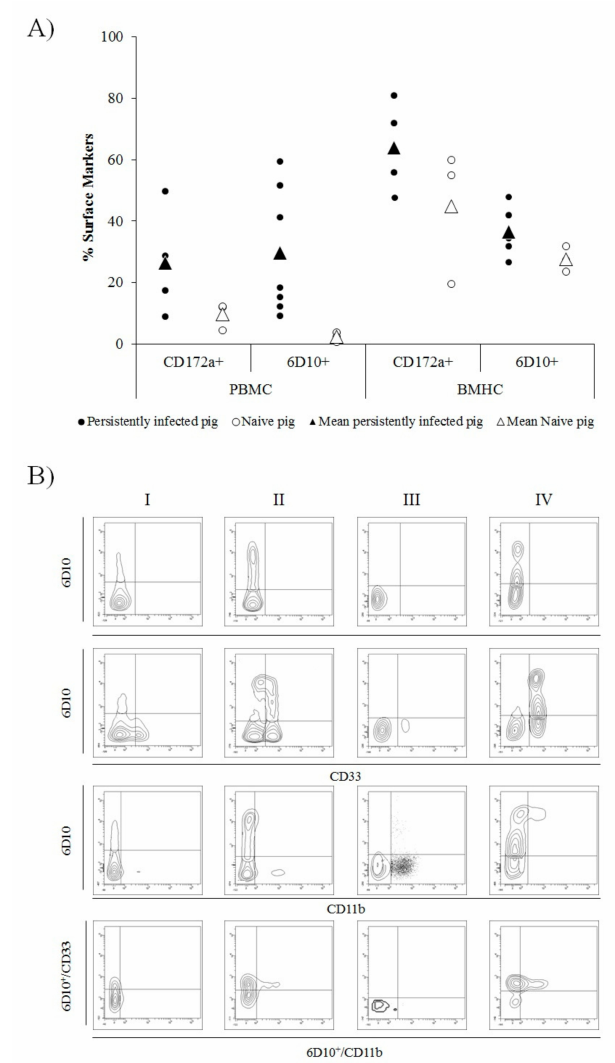
Figure 3. Illustration of cell surface markers in peripheral blood mononuclear cells (PBMC) and bone marrow haematopoietic cells (BMHC) from CSFV persistently infected and naïve animals at 6 weeks of age. ( A ) Comparative expression of CD172a (myelomonocytic cells) and 6D10 (granulocyte lineage) cell surface markers in PBMCs and BMHCs from CSFV persistently infected (black dots) and naïve (white dots) animals. Mean values for each group are indicated (triangle symbol). ( B ) Comparative expression of MDSC surface markers labelled by single (6D10), double (6D10 / CD33 and 6D10 / CD11b), and triple (6D10 / CD33 / CD11b) staining in di ff erent cell populations (in the bottom panels, 6D10 + cells were gated and the expression of CD33vs CD11b analysed). The cell populations evaluated were: I) BMHC from a naïve animal, II) BMHC from a CSFV persistently infected animal, III) PBMC from a naïve animal, and IV) PBMC from a CSFV persistently infected animal. The experiments were repeated twice under the same